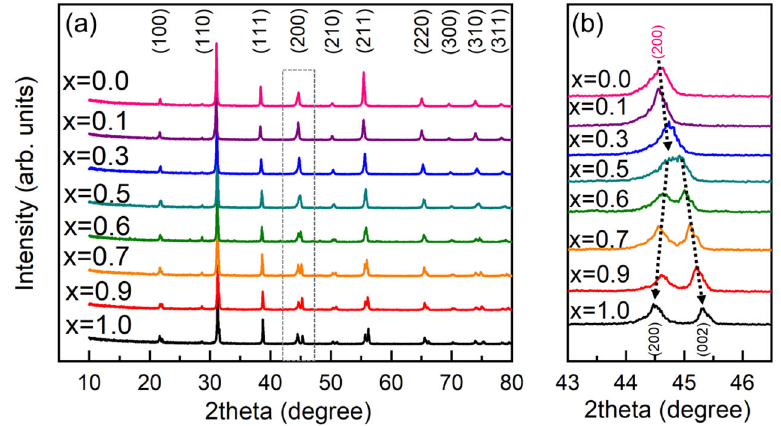
Figure 1. XRD profiles ( a ) and the (200) reflections ( b ) of the BZ 0.18 T–xBP 0.22 T ceramic powder samples at room temperature (22 ◦ C).